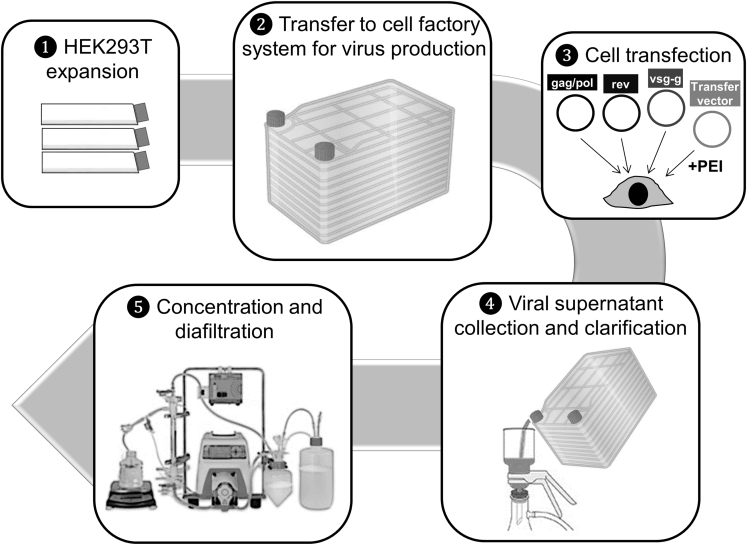
Diagram Depicting the Main Steps of Large-Scale CAR19 Lentivirus Production as Currently Established at Hospital Clínic de Barcelona